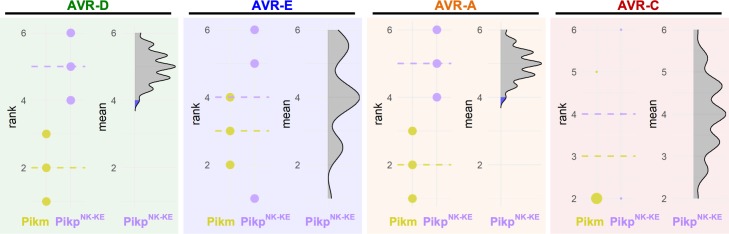
Estimation graphics for cell death, Pikm vs PikpNK-KE.Statistical analysis by estimation methods of the cell-death assay for Pikm and PikpNK-KE. For each effector, the panel on the left represents the ranked data (dots) for each NLR, and their corresponding mean (dotted line). The size of the dots is proportional to the number of observations with that specific value. The panel on the right shows the distribution of 1000 bootstrap sample rank means for PikpNK-KE. The blue areas represent the 0.025 and 0.975 percentiles of the distribution. The responses of Pikm and PikpNK-KE are considered significantly different if the Pikp rank mean (dotted line, left panel) falls beyond the blue regions of the PikpNK-KE mean distribution.